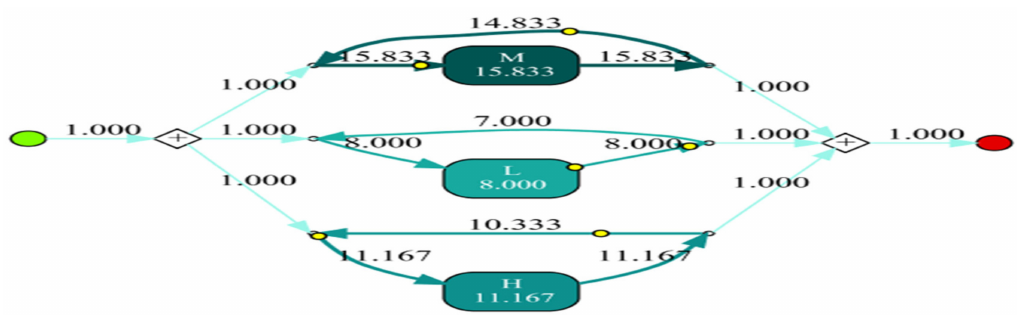
Figure 13. IvM process model with the relative paths shown for all student